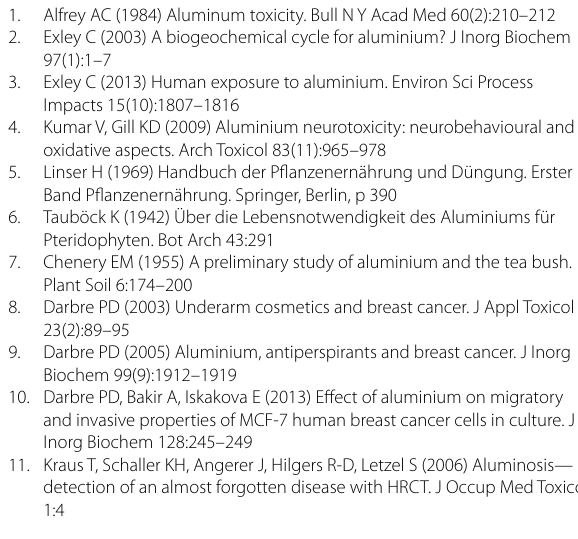
LOQ limit of quantification a List of ingredients according to the manufacturer: sugar, glucose, acidifier citric acid, cold-water soluble black tea extract 1.28%, vitamin C, lemon extract powder (maltodextrin, lemon juice concentrate), aroma